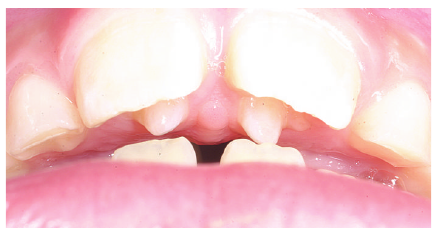
Figure 3: Presence of occlusal interference and premature contacts with the antagonist